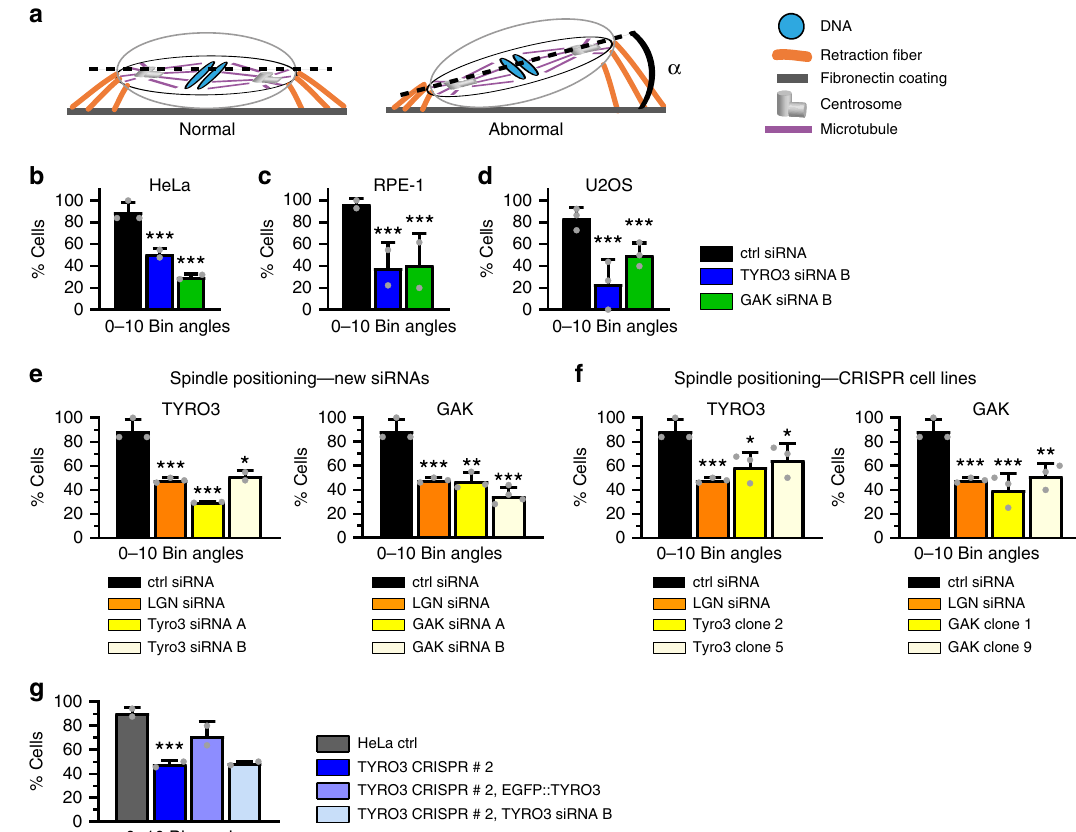
Fig. 3 Validation of cyclin G-associated kinase (GAK) and tyrosine receptor kinase 3 (TYRO3) spindle positioning phenotypes. Shown are percentages of cells with spindle positioning angles ( α ) between 0 and 10°. a Schematic representation of a control cell (left) or a cell with abnormal spindle positioning (right) seeded on a coverslip coated with uniform fi bronectin as used in experiments reported in b – g . b – d Mean values (±SD) of spindle positioning angle α in HeLa ( b ), RPE-1 ( c ), or U2OS cells ( d ). Number of cells analyzed from two ( d ) or three ( b , c ) independent experiments: HeLa ctrl: 30, HeLa TYRO3: